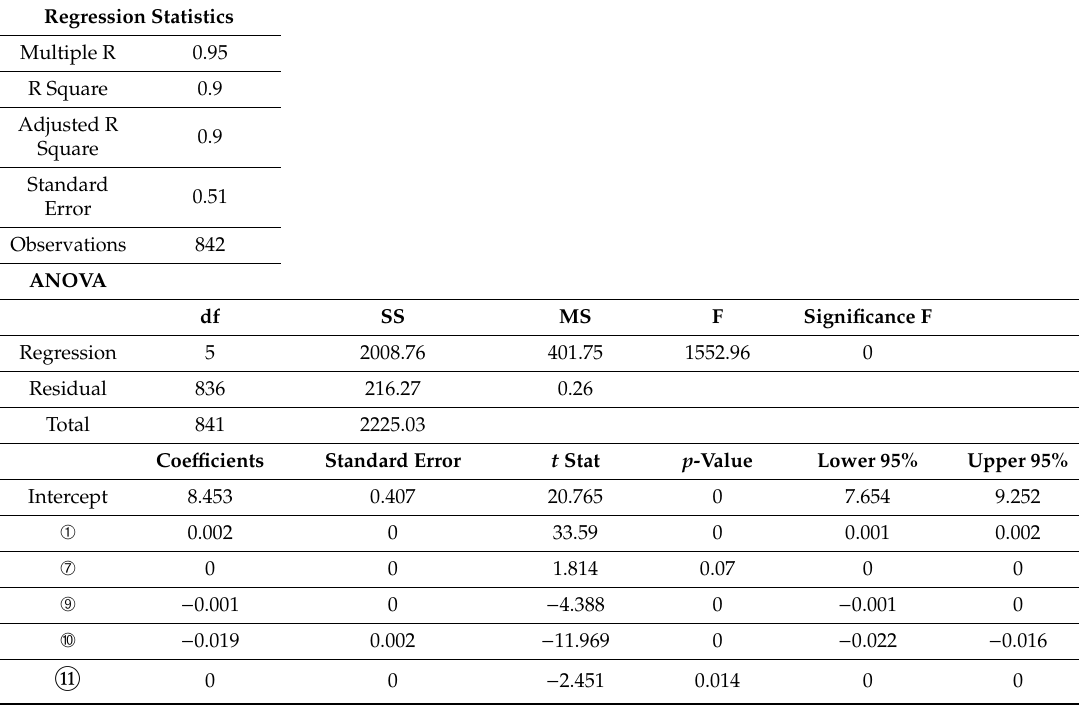
Table 6. Correlation between heating load of air-based solar heating system and climatic factors (five items).